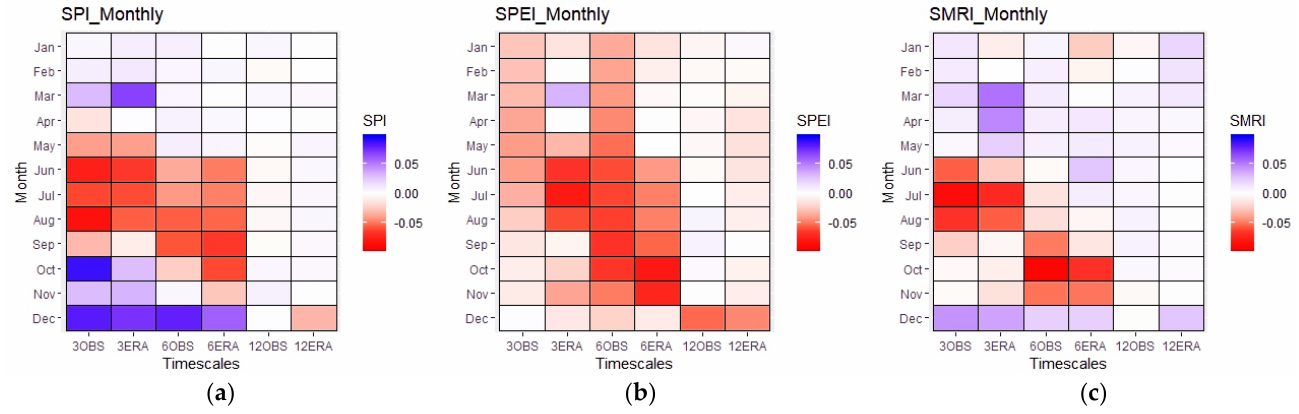
Figure 7. Monthly distribution of Indices ( a ) SPI, ( b ) SPEI, ( c ) SMRI.